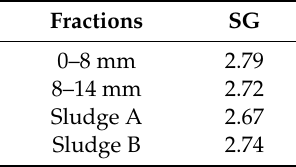
Figure 1. Particle size distribution of aggregate fractions and sawing sludge. Table 2. Specific gravity of aggregate fractions and sawing sludge.